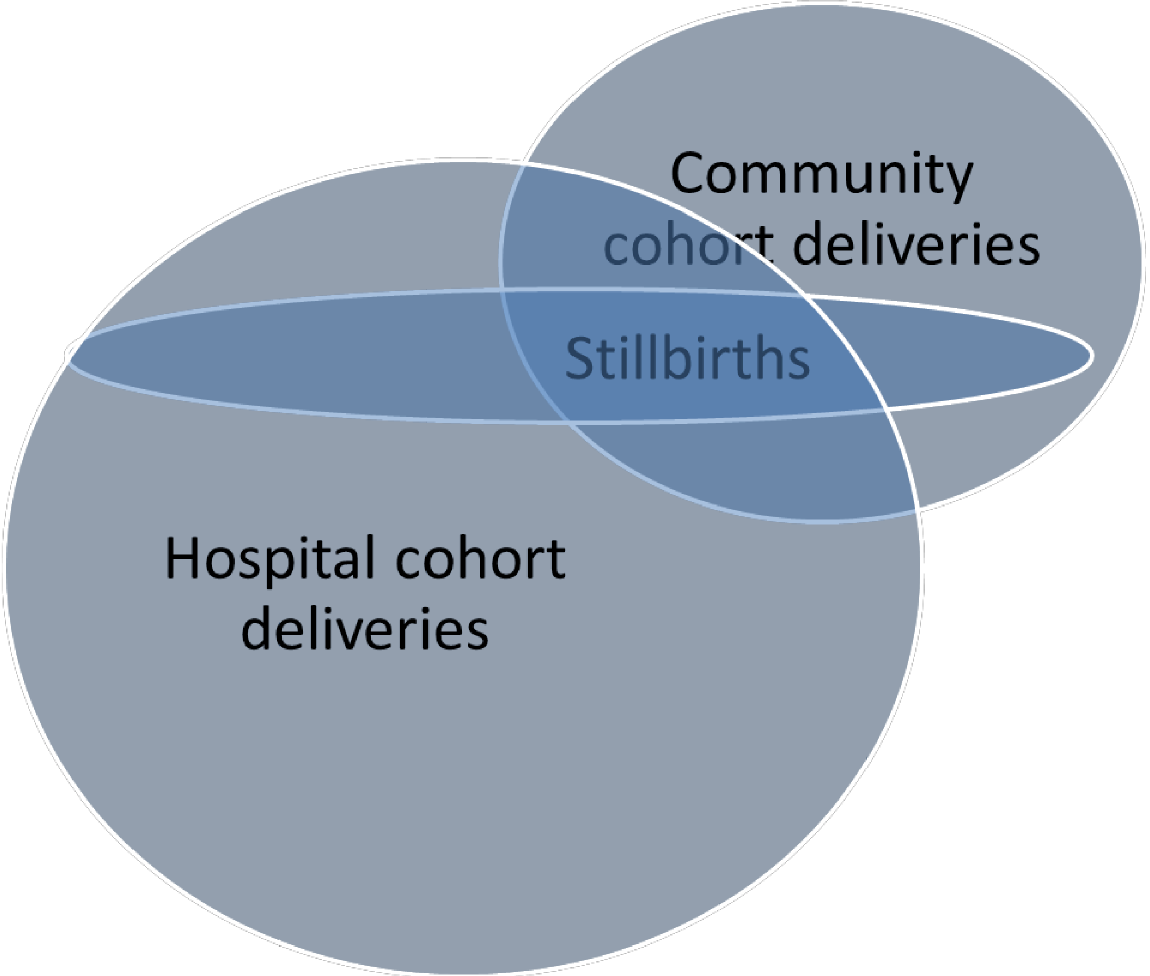
Fig 1. Overlap between births from the BHP study area (community cohort) and births at the HNSM hospital. The figure illustrates that there was a substantial overlap between the two cohorts, i.e. a significant proportion of community cohort births occurred at the HNSM.